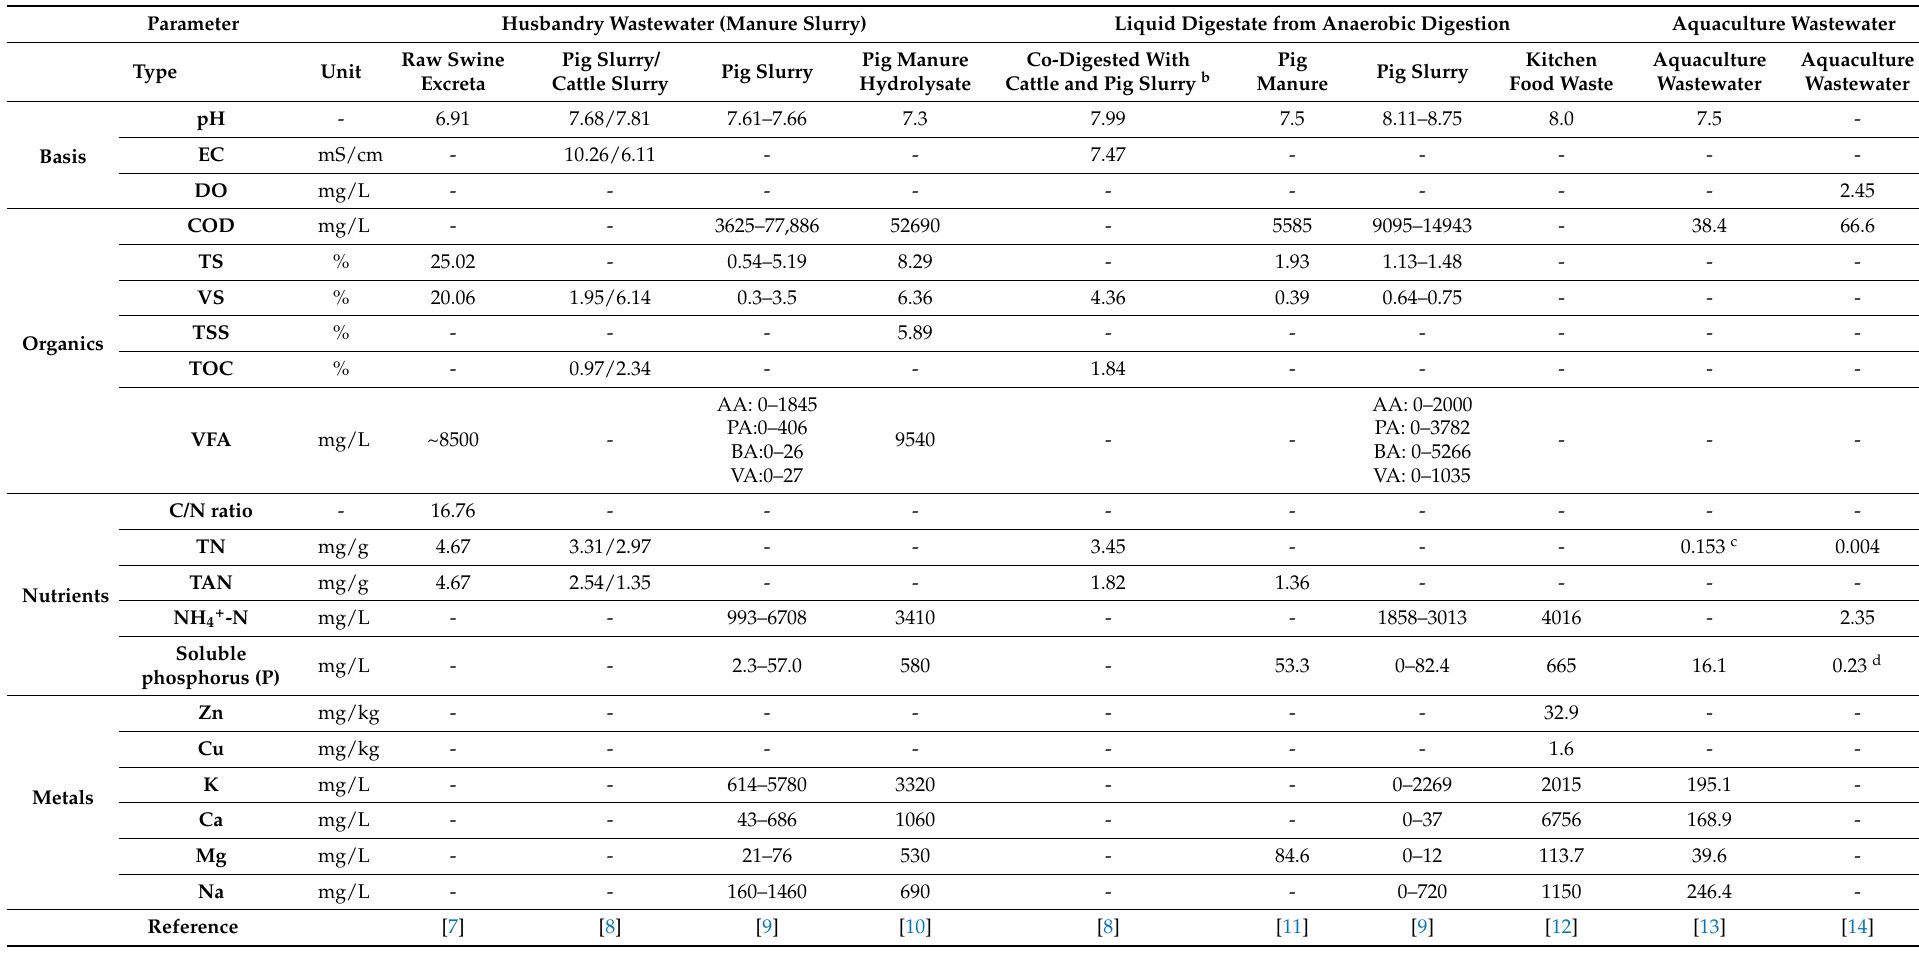
Table 1. Physicochemical characteristics of different agricultural wastewaters reported in the literature.